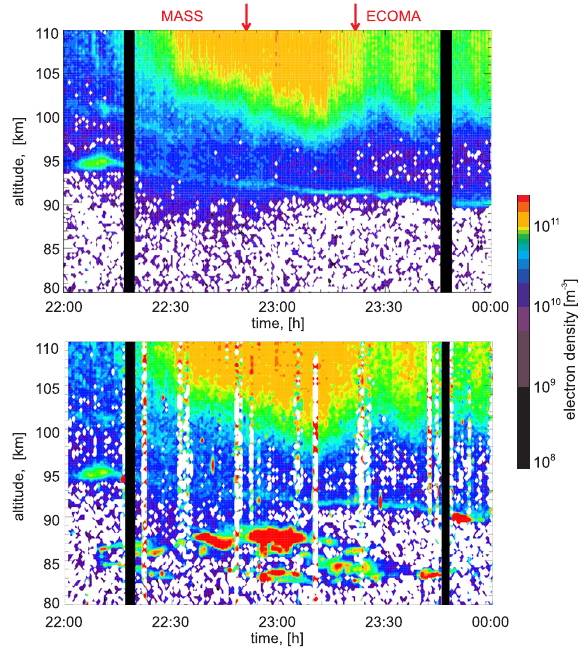
Fig. 1. Electron densities derived from measurements with the EIS- CAT UHF- (upper panel) and VHF-radar (lower panel). Note that the very strong signals seen in the VHF-radar between 80 and 90km may not be interpreted as electron densities but origin from coher- ent scatter owing to PMSE. The times of the MASS and ECOMA rocket launches are indicated by red vertical arrows at the top of the figure. Black vertical stripes indicate times when the measurements were interrupted.